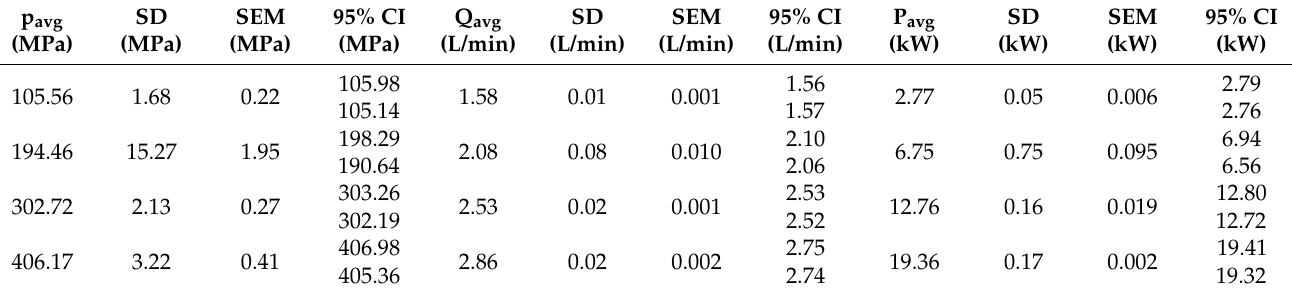
Table 1. Results of the measured feeding water pressures, volume flow rates, and power distribution in the water nozzle.